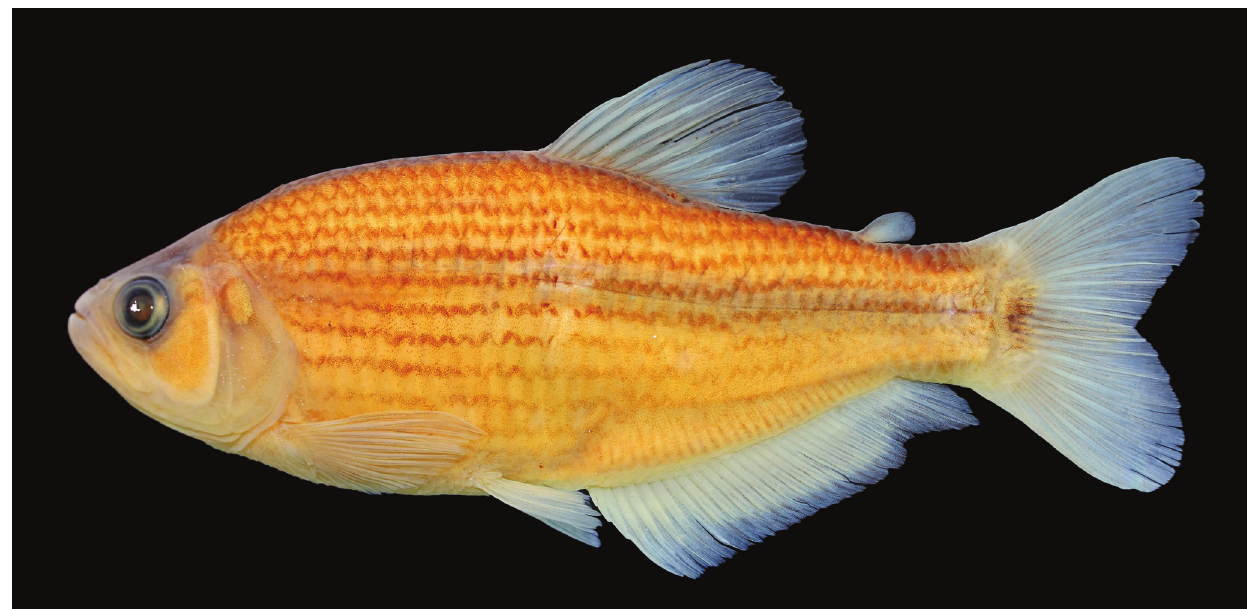
Fig. 1. Hollandichthys taramandahy , MCP 30000, holotype, male, 85.8 mm SL, tributary of rio do Ouro, Barra do Ouro, Maquiné, Rio Grande do Sul,